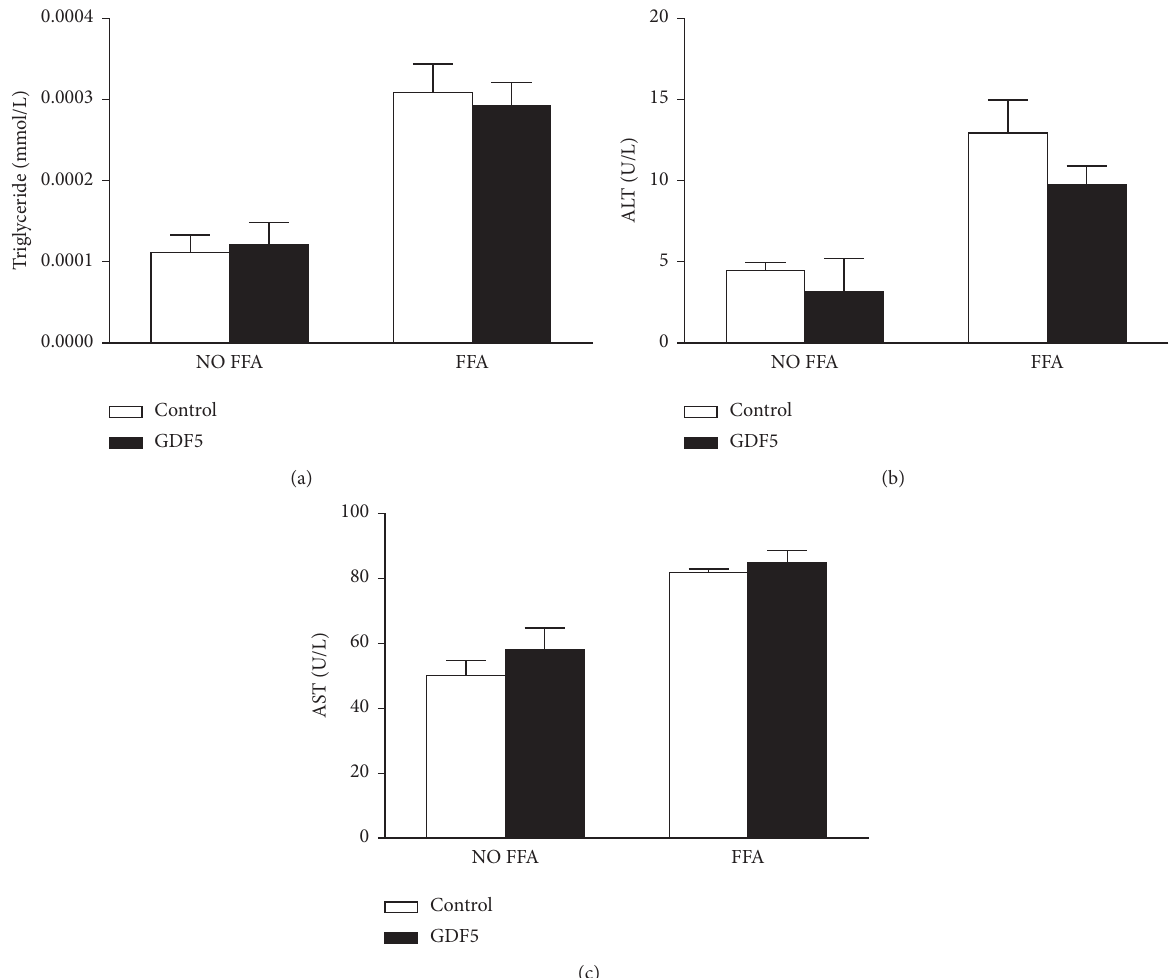
Figure 4: Triglyceride levels and ALT/AST alterations in LO2 cells after FFA induction . (a) The concentration of triglyceride in LO2 cells treated with/without FFA in the GDF5 overexpression and control groups. (b) The concentration of ALT in LO2 cells treated with/without FFA in the GDF5 overexpression and control groups. (c) The concentration of AST in LO2 cells treated with/without FFA in the GDF5 overexpression and control groups ( ∗ : P < 0 . 05; ∗∗ : P < 0 .